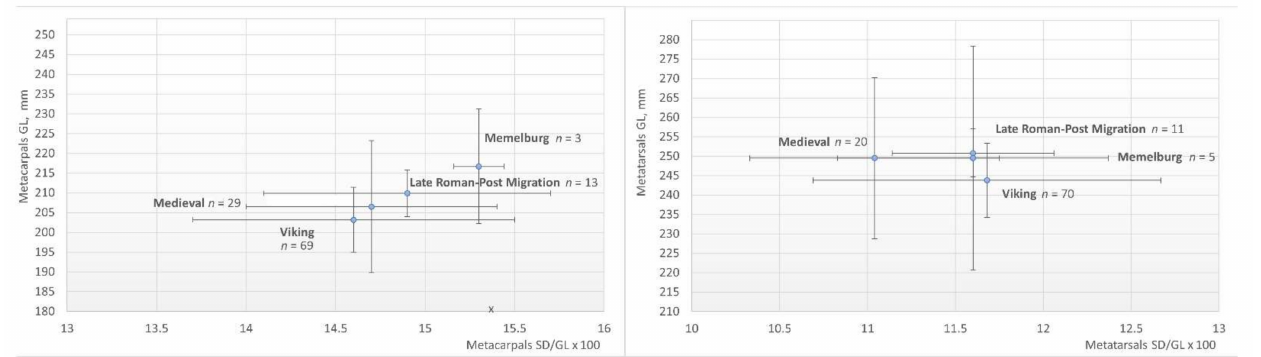
Figure 7. Mean SD/GL ratio through time for metacarpal and metatarsal bones. Bars are mean ± SD.